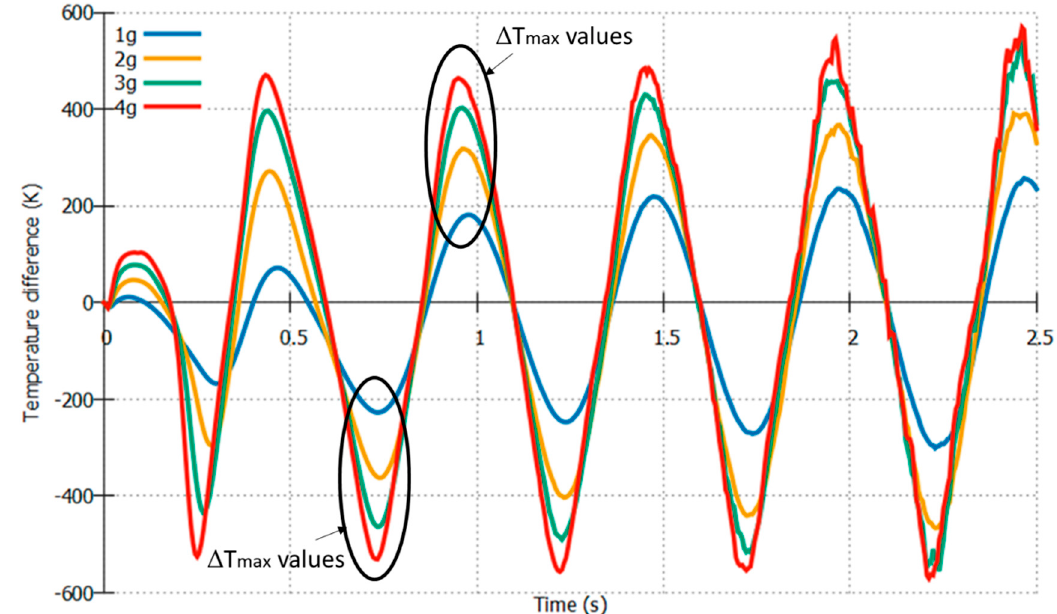
Figure 8. Temperature difference between sensors Y32 and Y31 w.r.t time at 4 π rad/s with varying acceleration.